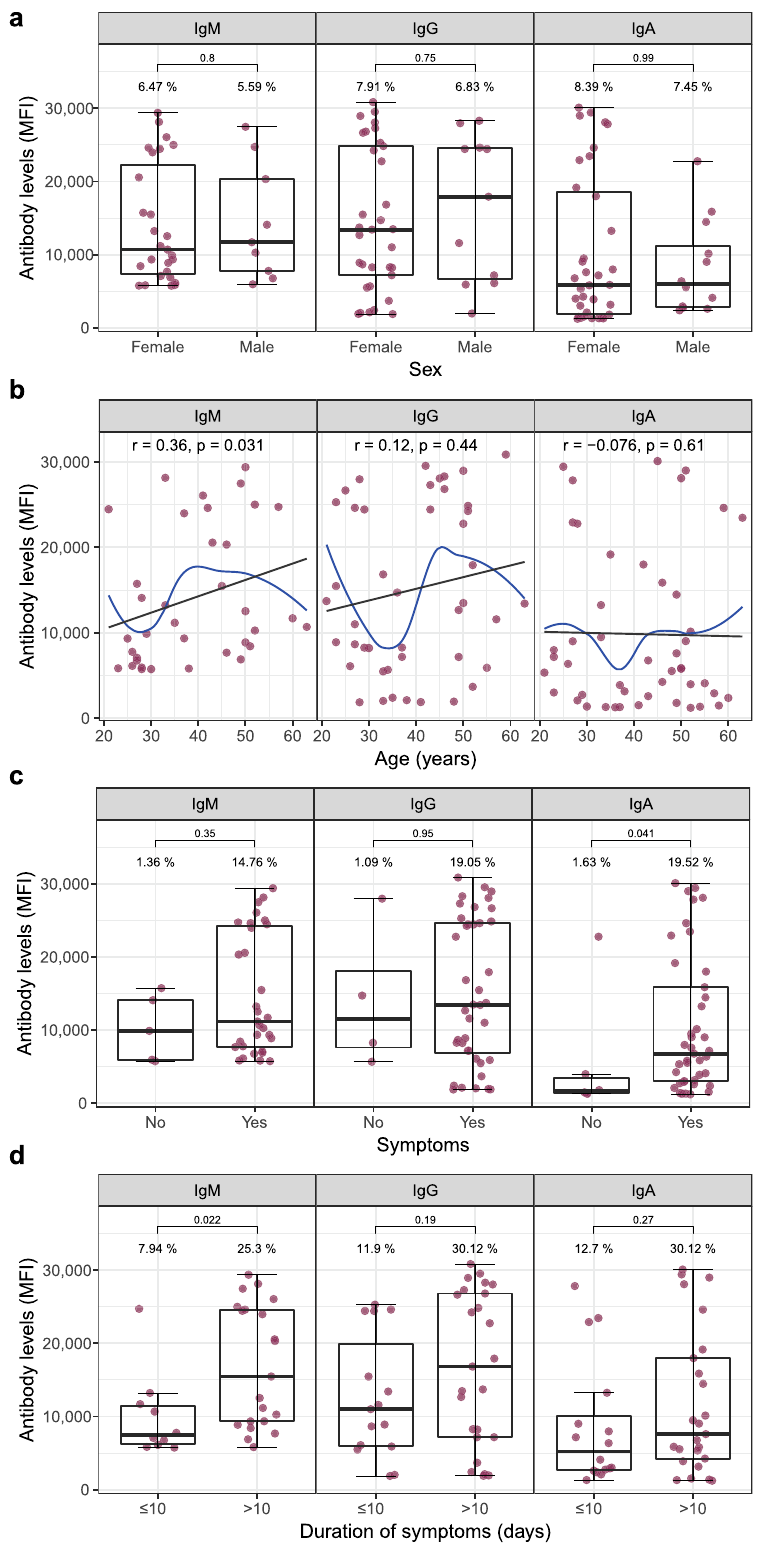
initial days after symptoms onset. Given the current lack of evi- dence on the correlation of SARS-CoV-2 antibody levels and protection against reinfection, no recommendations should be derived for seropositive HCW at an individual level. This study also shows that around 46% of undiagnosed infections occur in